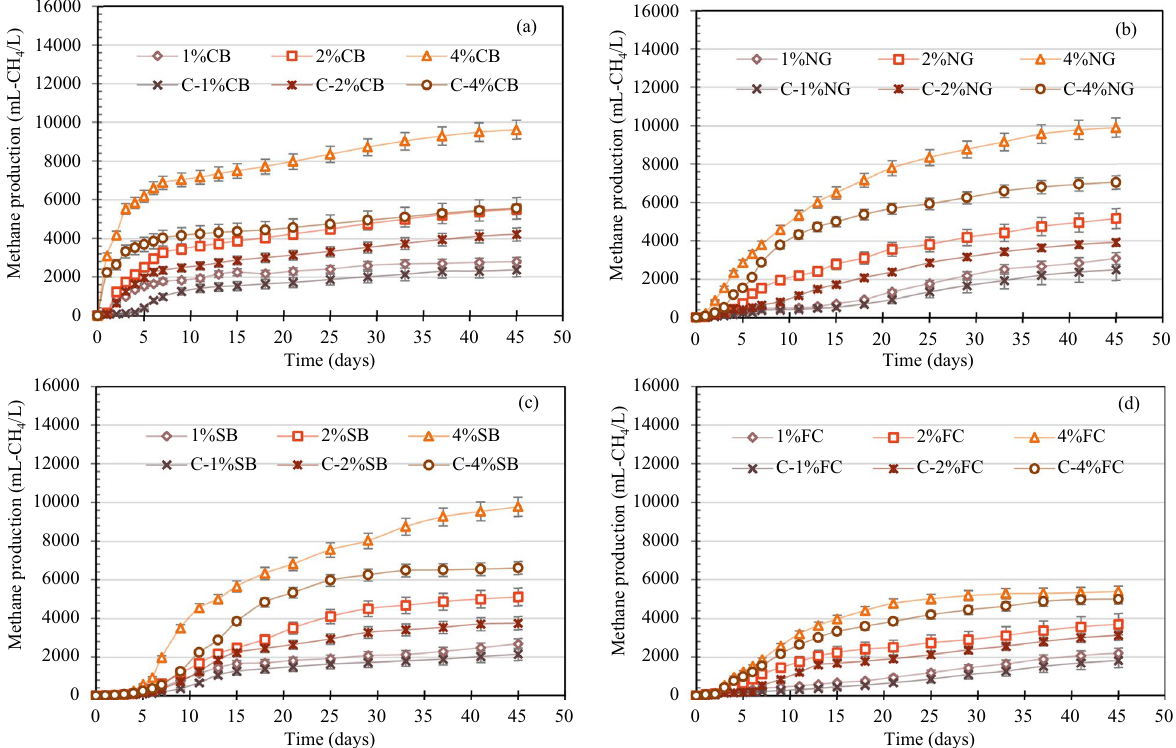
Figure 7. Methane production from bioaugmentation treatment at 1, 2, and 4% initial volatile solid concentration (IVC) of each substrate, including cassava bagasse (CB) ( a ), Napier grass (NG) ( b ), sugarcane bagasse (SB) ( c ), and filter cake (FC) ( d ). C (control) indicates the non-bioaugmentation treatment at various %IVC of each